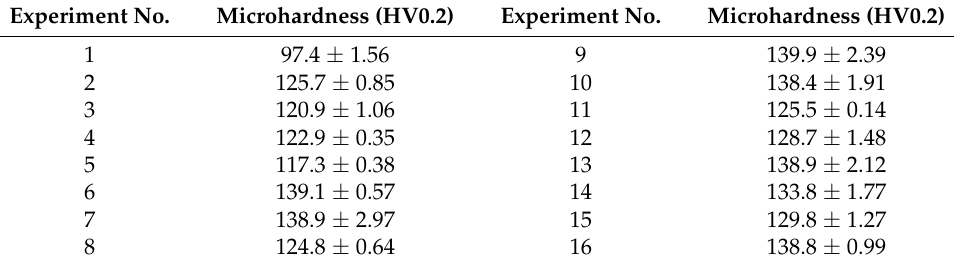
Table 4. The average hardness value of the upper surface of the sample.